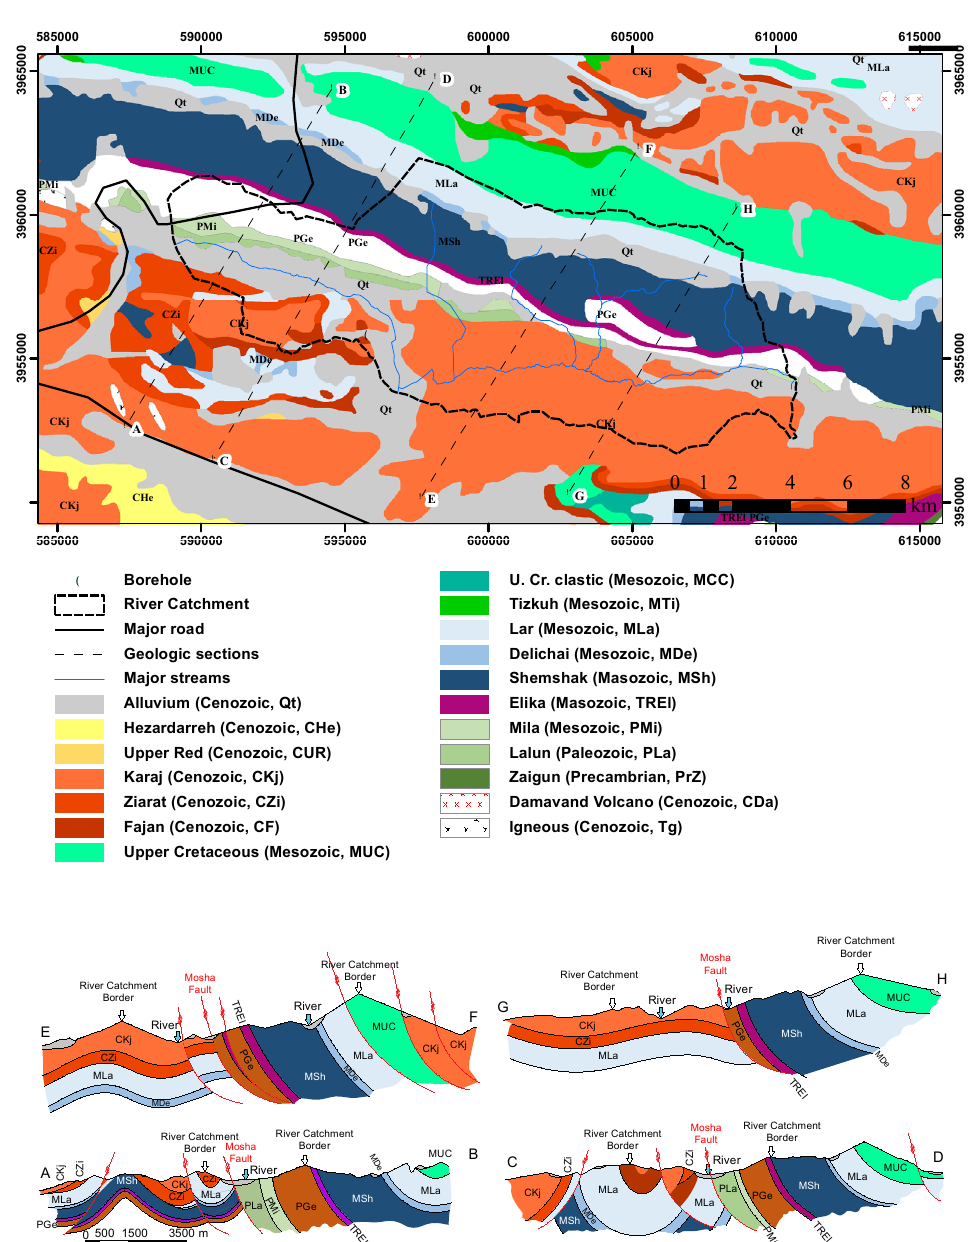
Figure 1. Geological map and cross ‐ sections of the study area. The Mosha Plain study area is located in a marginal climate zone, where the northern section of the river catchment is of the very wet climate type, but the southern section is of the wet climate type. Regarding the long ‐ term meteorological data (2015–2019), the an ‐ nual average air temperature and average annual precipitation are 13.35 °C and 394.3 mm, respectively [47]. The average depth of the groundwater level in alluvial and fractured rock aquifers is 12.4 and 19.8 m, respectively. Considering the water table in the wells and the surface topography, the general groundwater flow direction follows the Mosha Fault zone and the F ‐ 1 Fault zone southward (Figure 2).